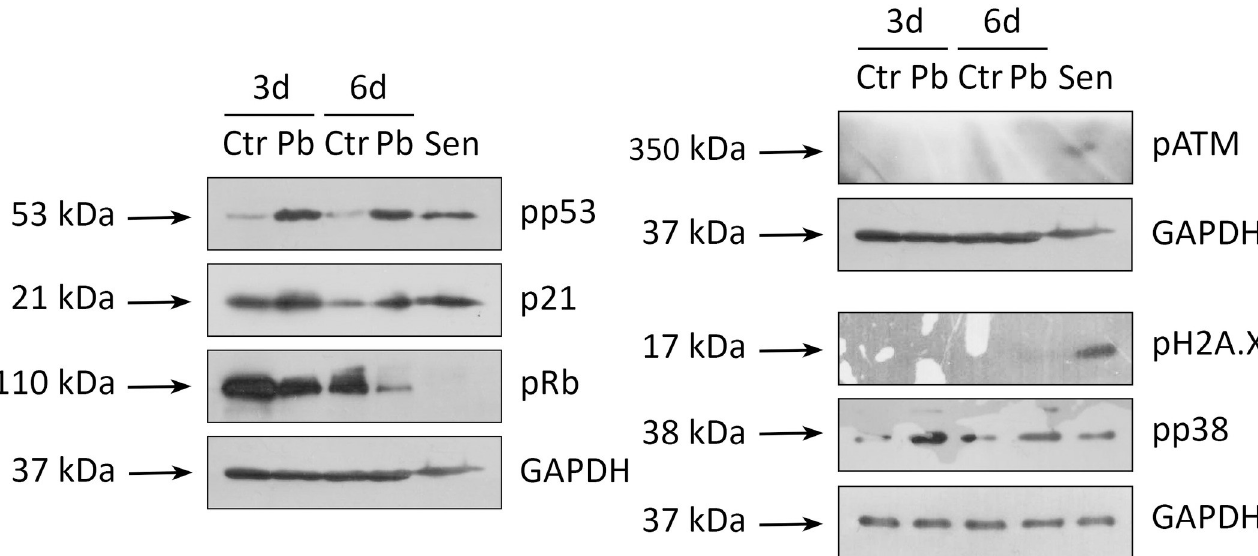
Fig 3. Pb stimulates activation of both p53/p21/Rb and p38 MAPK pathways in hMESCs. “Ctr”–control cells, “Pb”–Pb-treated cells, “Sen”–senescent hMESCs (senescence was induced as described previously [15]). Western blot analysis for pp53, p21, pRb, pp38, pATM and pH2A.X was performed at indicated time points. GAPDH was used as loading control. Representative results of the three experiments are shown in the Figure.